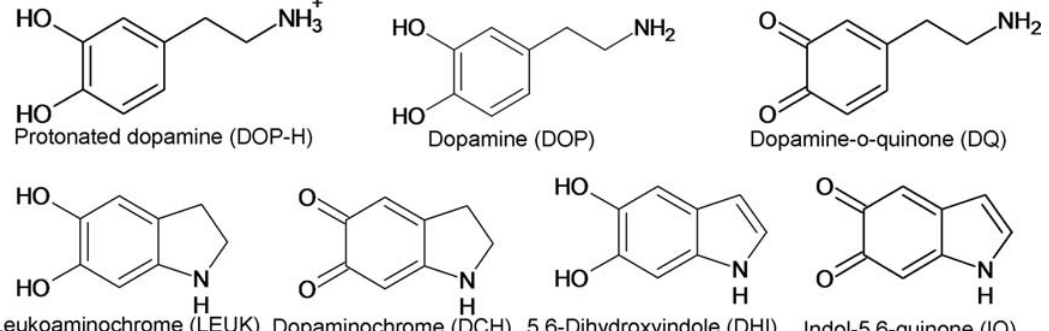
Figure 1. Dopamine docked onto AS: chemical formulas of the proposed dopamine forms binding to AS [ 42 ] .